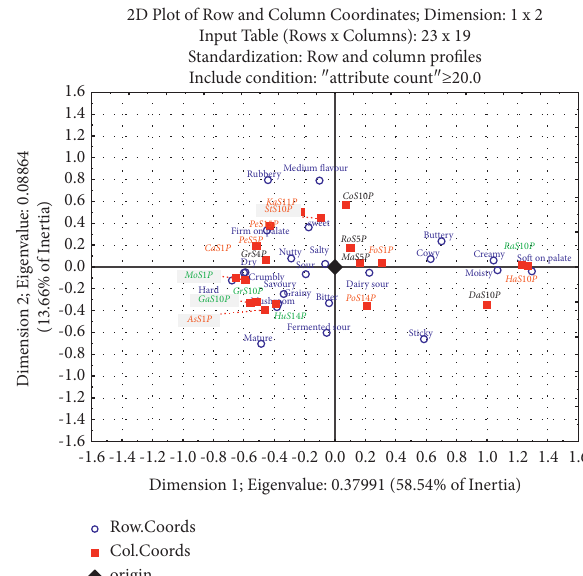
Figure 7: Representation of samples with texture and flavor sensory attributes in the first two dimensions of the CA plot performed on data from sorting of the “other” group ( n � 19). For cheese codes, the 1 st 2 letters refer to the cheese type, S1 to S15 refer to the supplier, and P (pasteurized) and R (raw) refer to the milk type. Color codes: black: 1 month; orange: 3 months; green: 6 months.